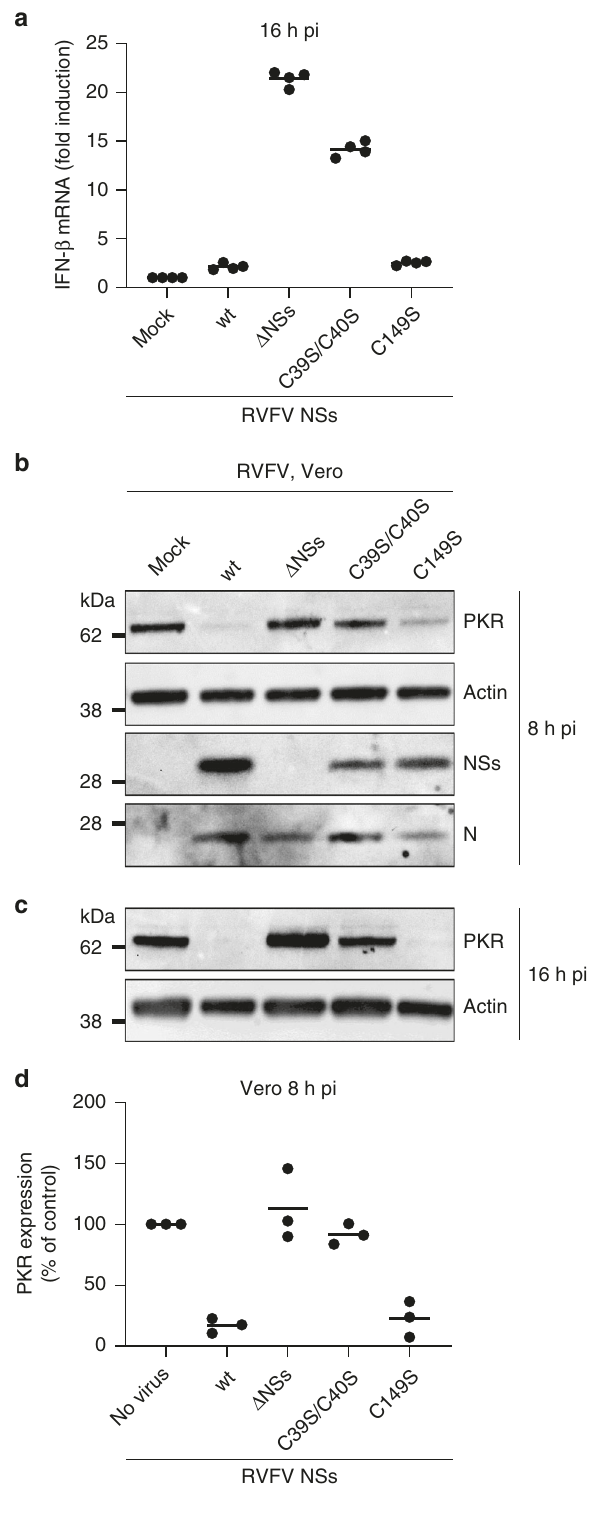
Fig. 8 NSs fi brils suppress IFN responses. a A549 cells were infected with either RVFV, RVFV Δ NSs, or the mutant viruses NSs C39S/C40S and C149S (MOI ~4) for 16 h. Infected cells were then lyzed and total RNA was extracted and puri fi ed. IFN- β mRNA levels were quanti fi ed by qRT-PCR. Points represent replicates ( n = 4). Experiments were repeated independently twice with similar results. Center line, mean. b – d Vero cells were exposed to RVFV, RVFV Δ NSs, and the two mutant viruses NSs C39S/C40S and C149S (MOI ~5) for 8 h ( b ) and 16 h ( c ), and subsequently, lyzed and analyzed by SDS-PAGE and WB under reducing conditions with Abs against PKR, actin, NSs, and N. d Shows semi- quanti fi cation. Points represent independent experiments ( n = 3). Center line,